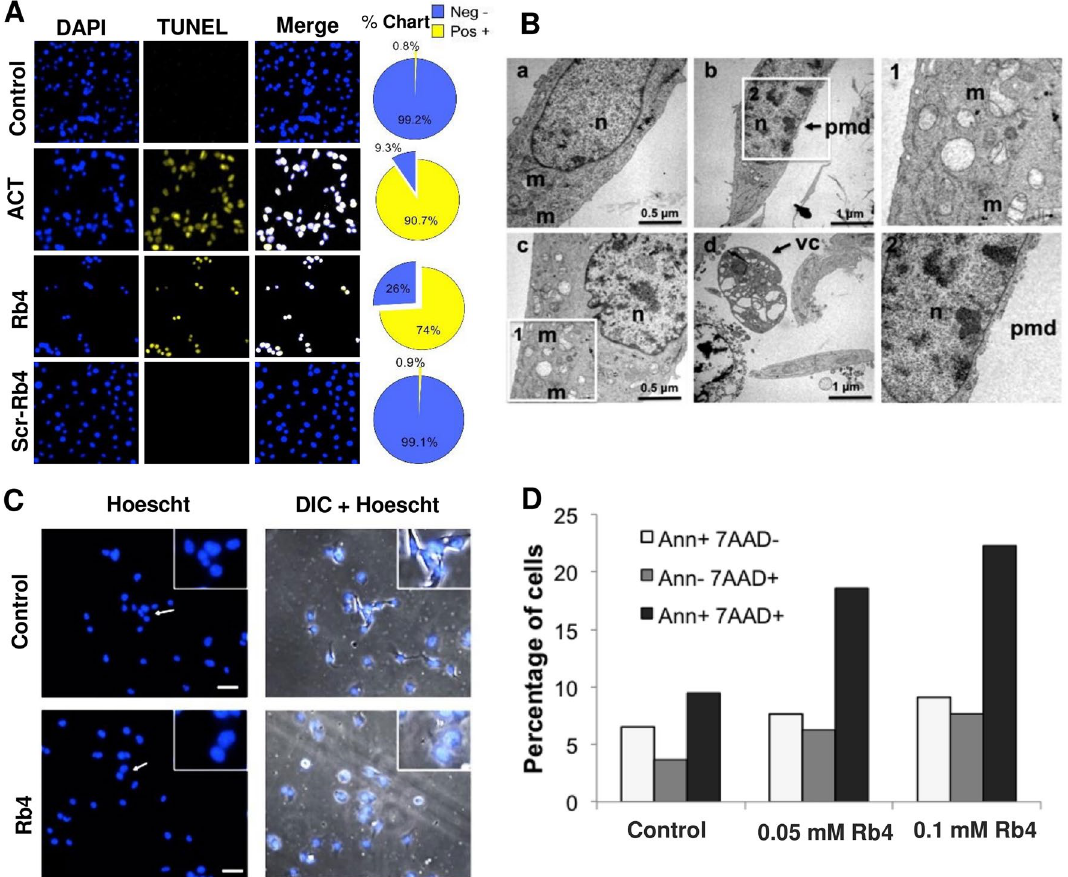
Figure 4. Cell death induced by Rb4 peptide. ( A ) Internucleosomal DNA degradation. B16F10-Nex2 cells were treated with 0.15 mM Rb4 or Scr-Rb4 for 16 h. The DNA of control cells and the treated cells were detected by TUNEL assay in fluorescence microscopy. 1 μg/ml actinomycin-treated (ACT) cells were used as a positive control. Bar 200 μm. Pie charts on the right show the percentage of positive cells (yellow) or negative (blue) of TUNEL assay. ( B ) Ultrastructural characteristics of Rb4-induced cell death. B16F10-Nex2 cells were either left untreated (control, a ) or treated with 0.15 mM Rb4 for 16 h ( b, c, d, 1, 2 ) followed by